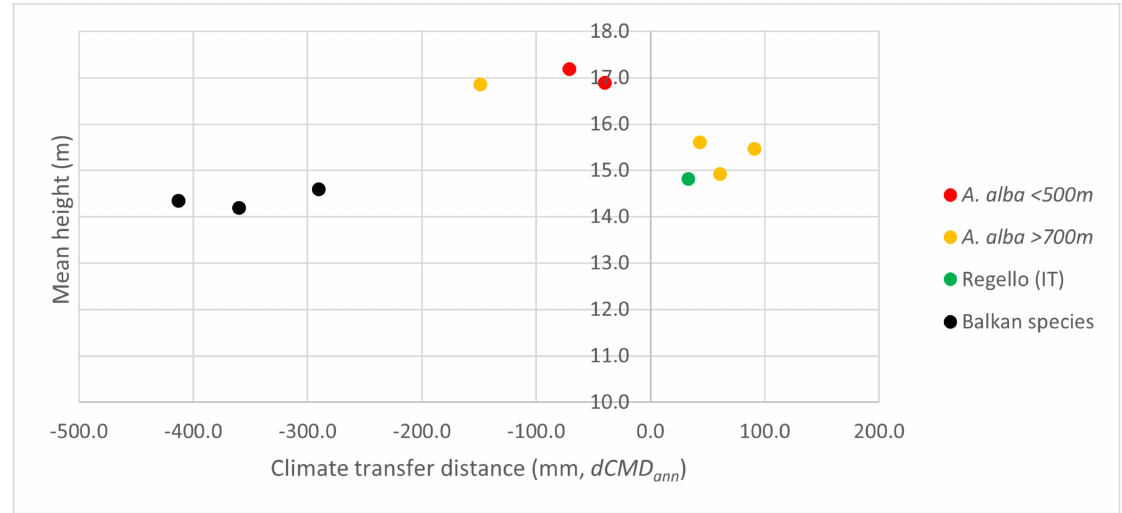
Figure 3. Mean height response of all provenances to climate transfer distance (current vs past) expressed in annual climatic moisture deficit (mm precipitation dCMD ann ) in the trial P í sek. The provenances A. cilicica and A. pinsapo are not shown, having suffered total mortality (see also Figure A1a,b for distances expressed in temperature and precipitation